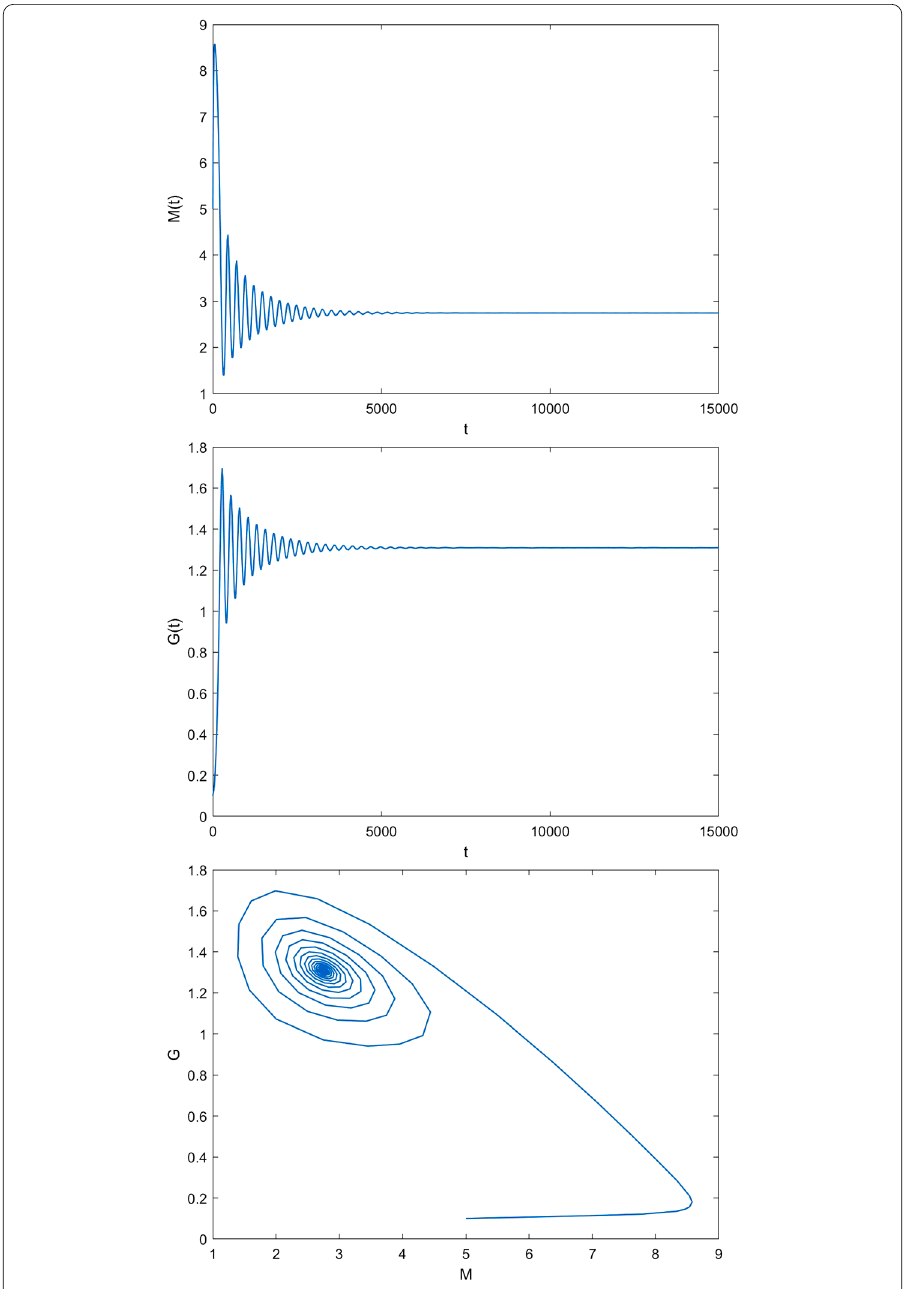
Figure 3 A computer simulation of the system (2.1)–(2.2) with a 1 = 0.1450, a 2 = 0.6937, b 1 = 0.0596, b 2 = 0.0206, α 1 = 0.16385, k 1 = 15.64, k 2 = 12.4113, τ = 22 < τ 0 = 22.5131, where M (0) = 5 and G (0) = 0.1, for which all conditions in Theorem 2(b) are satisfied. The solution trajectory tends towards a non-washout steady state as theoretically predicted